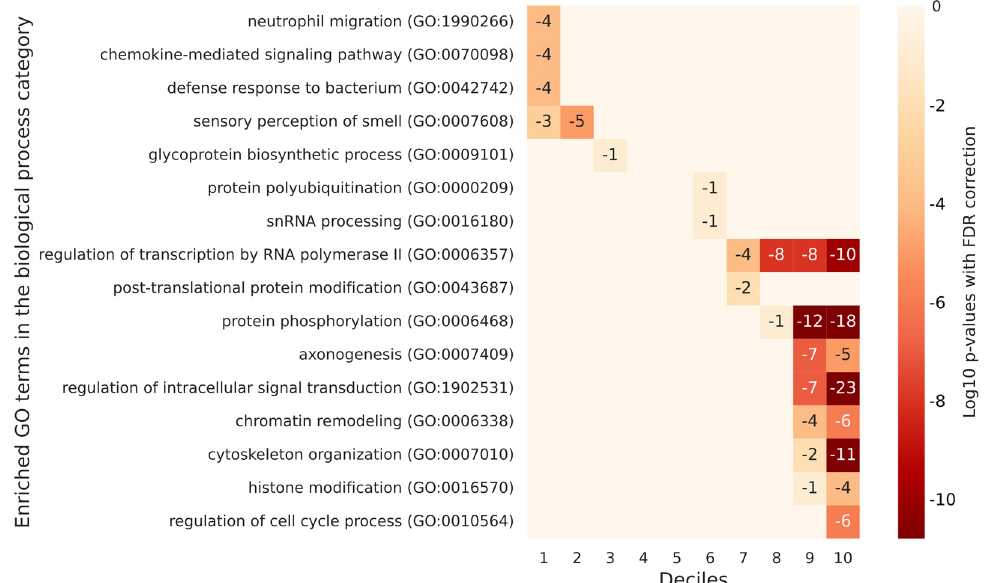
Figure 6. A heatmap of selected GO enrichments identified for human proteins grouped by decile based on their number of phosphorylation sites. The figure lists the significant GO enrichments by biological process terms for each decile of human proteins defined according to their degree of phosphorylation. Each table row represents a different GO term, and each column represents a different decile. The numbers in the cells are the log10 p -values with FDR correction of the enrichment of a decile with a specific GO term. Empty cells are associated with a log10 p -value of 0, which corresponds to a p -value of 1 and is not significant. In humans, non-phosphorylated proteins (those in the first two deciles) have a role in the immune response and perception. The most phosphorylated proteins (belonging to the last four deciles) have multiple regulatory roles and functions related to development and